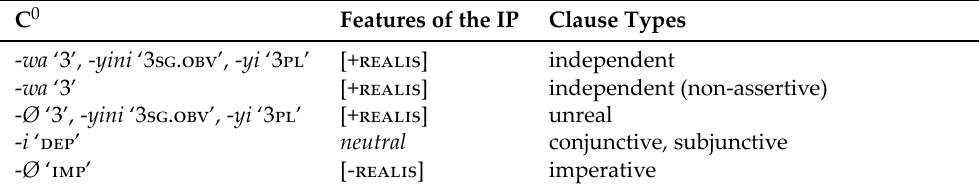
Table 1. Dependencies between C 0 and IP